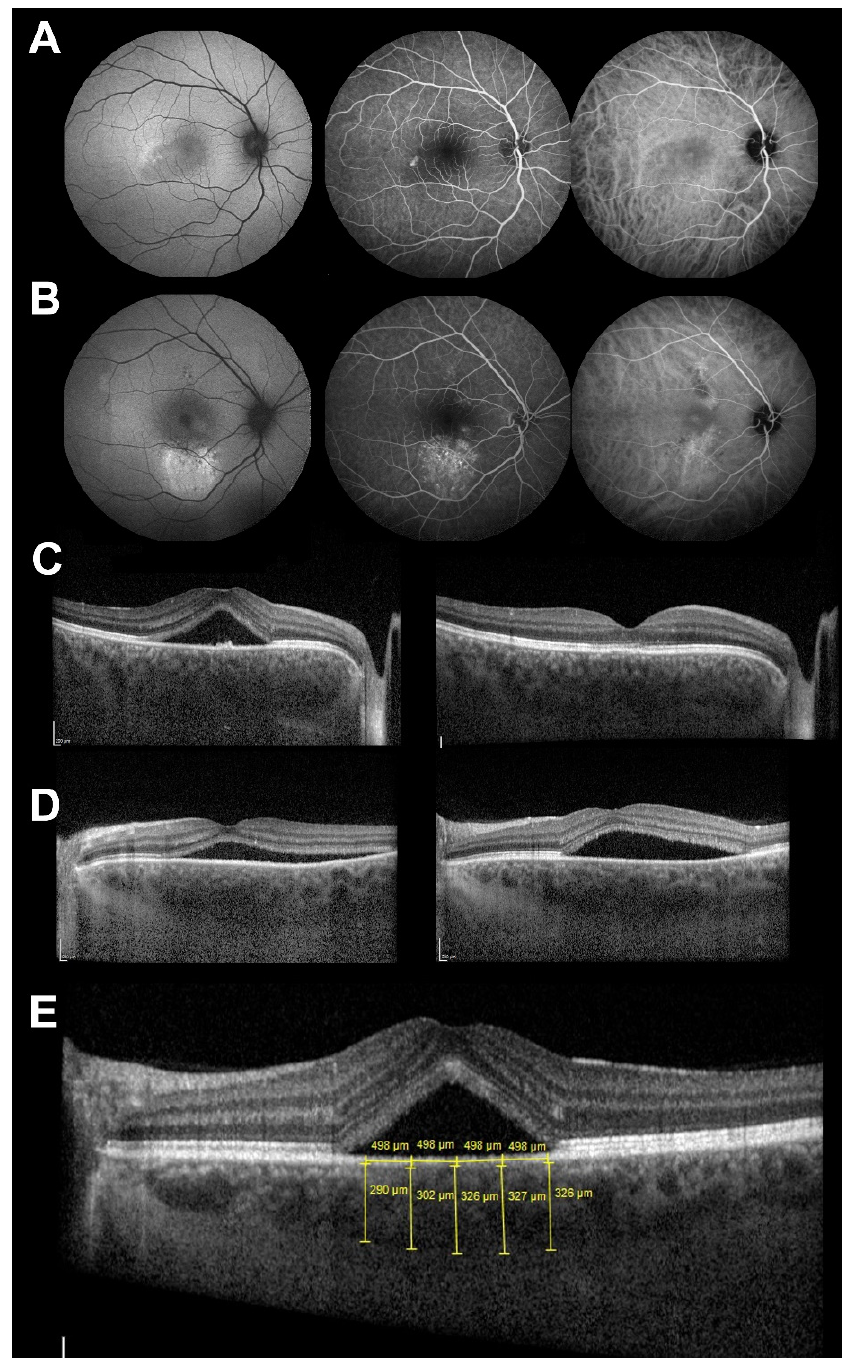
Figure 1. ( A , B ) Central serous chorioretinopathy (CSC) clinical features on multimodal imaging to confirm the diagnosis in two patients; ( C ) optical coherence tomography (OCT) of a patient with spontaneous CSC episode resolution; at baseline (left) and 3 months thereafter (right); ( D ) OCT of a patient with persistent CSC episode; at baseline (left) and 3 months thereafter (right); ( E ) Measurement of choroidal thickness with enhanced depth imaging OCT. Average of five measurements was calculated and used as the choroidal thickness.